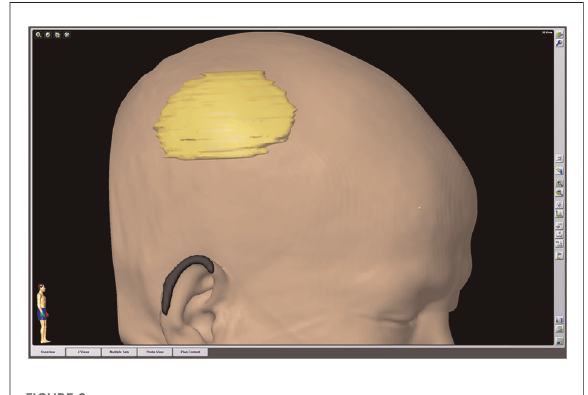
FIGURE 2 The extent of the preoperatively planned resection was outlined by the neuronavigation system before surgery.